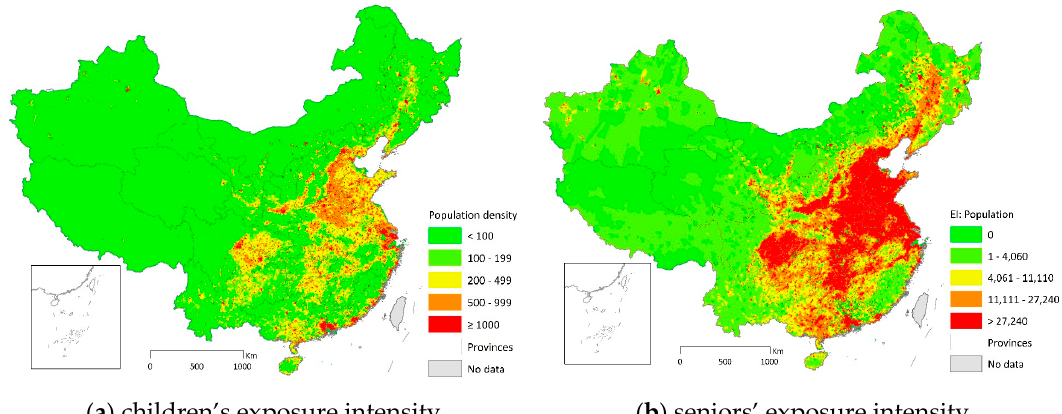
Figure 5. Exposure intensity (pollution days*persons per km 2 ) for the susceptible subpopulation: ( a ) children ( ≤ 14), and ( b ) seniors ( ≥ 65). Exposure intensity is the product of exposure duration and exposed population density. Exposure duration is the total number of days in a year exceeding China’s daily PM 2.5 standard. The spatial resolution is subdistrict.